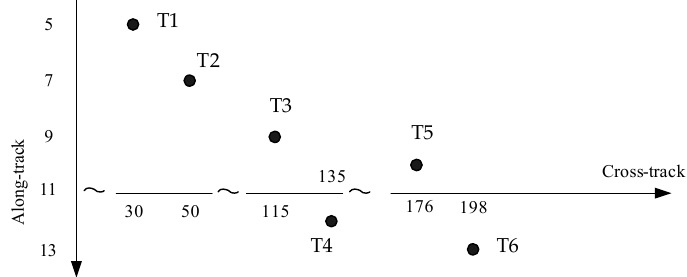
Figure 7. Distribution of simulation scene.